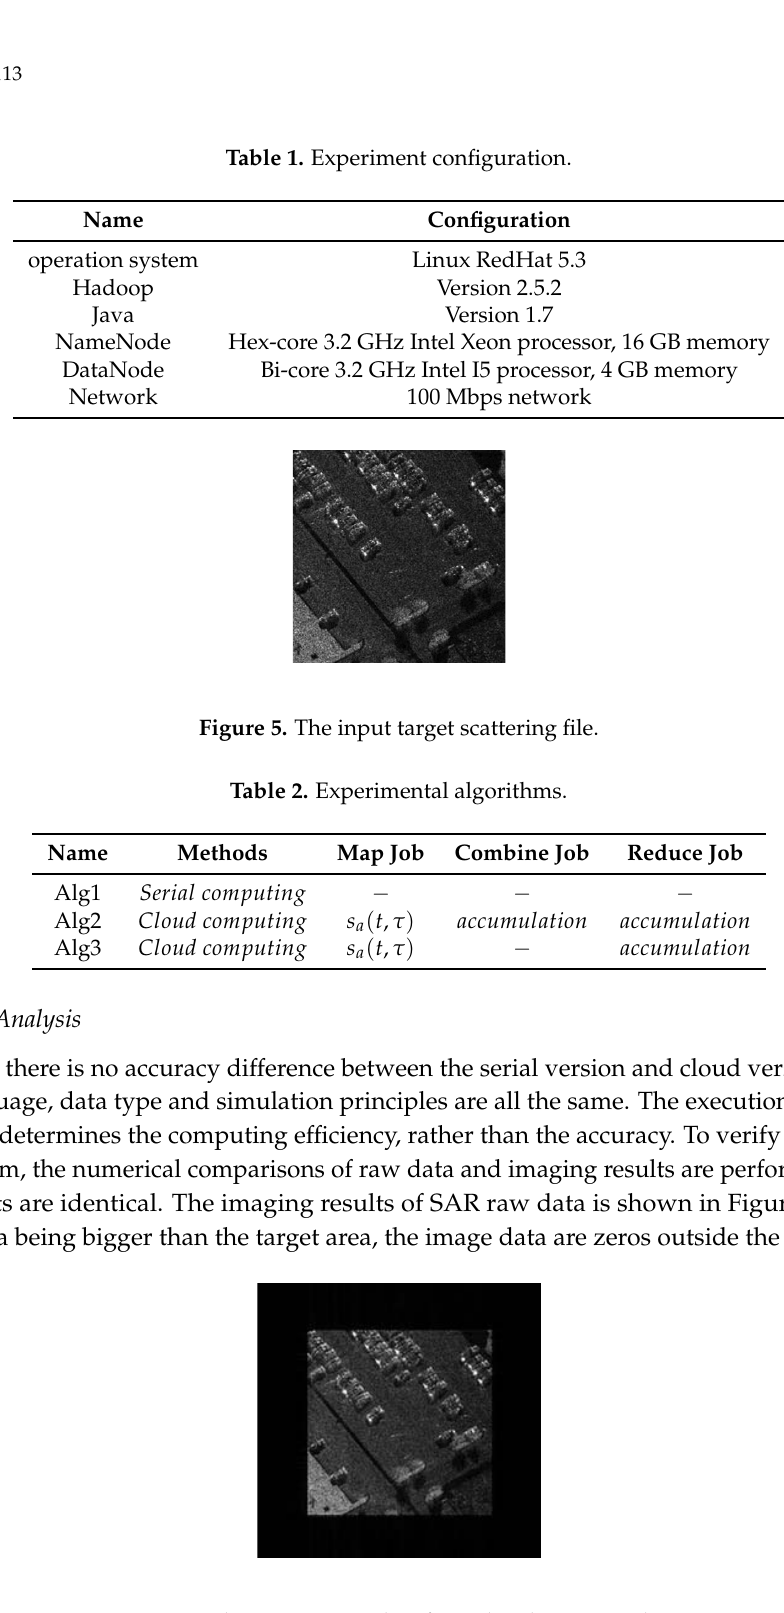
Figure 6. The imaging results of simulated SAR raw